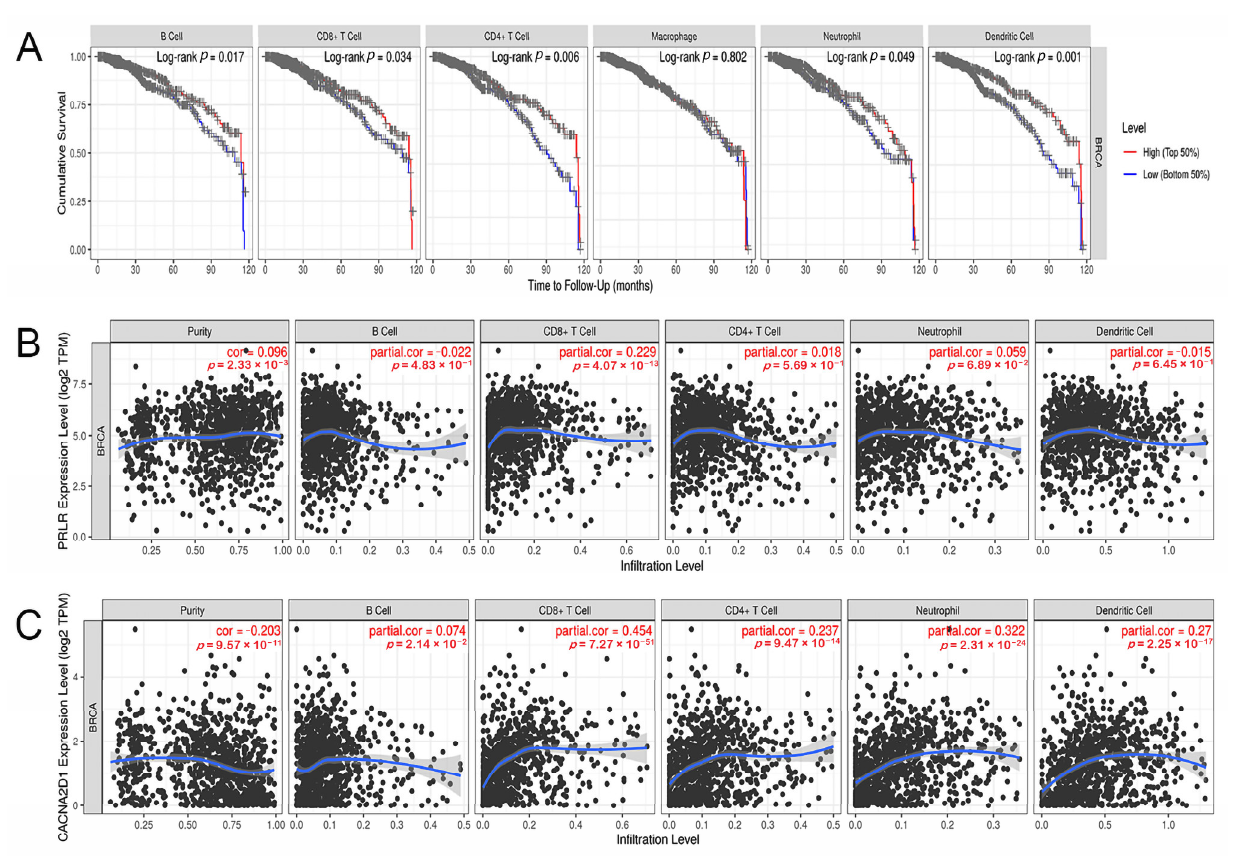
Figure 11. ( A ) Kaplan–Meier plots were used to analyze the immune infiltration and overall sur- vival rate of BRCA. ( B ) Correlation of PRLR expression with immune infiltration level in BRCA. ( C ) Correlation of CACNA2D1 expression with immune infiltration level in BRCA.